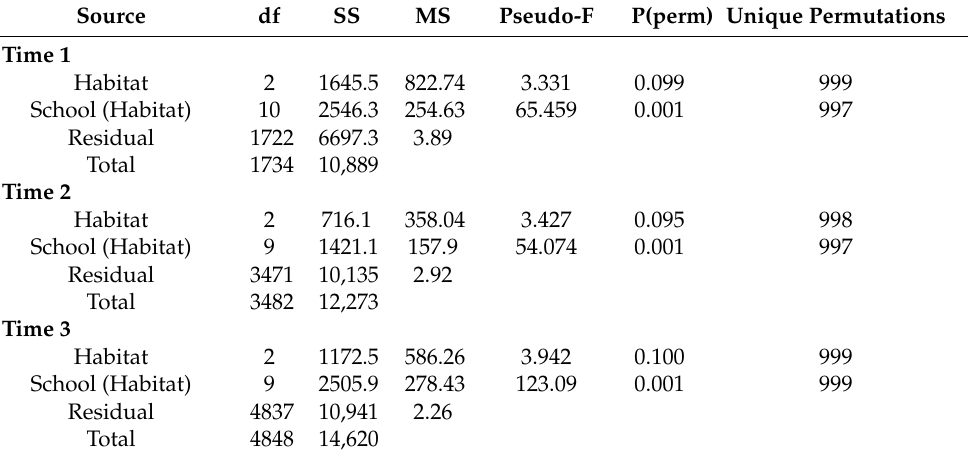
Table 3. Results of the univariate PERMANOVA on mean fork length of Haemulon resting schools in the Majimo/Caracoles area during the small-scale mark-recapture event. School is nested within the habitat. The analysis was run separately for three different sampling periods. df = degrees of freedom; SS = sums of squares; MS = mean square; P(perm) is the p -value derived from the permutations. Source df SS